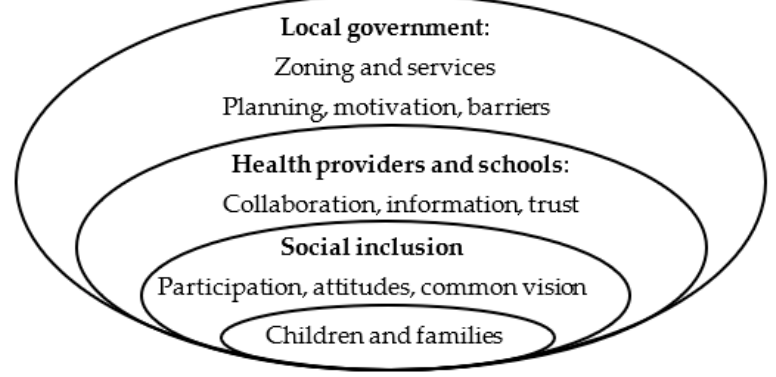
Figure 1. Research framework ‐ healthy places for children.